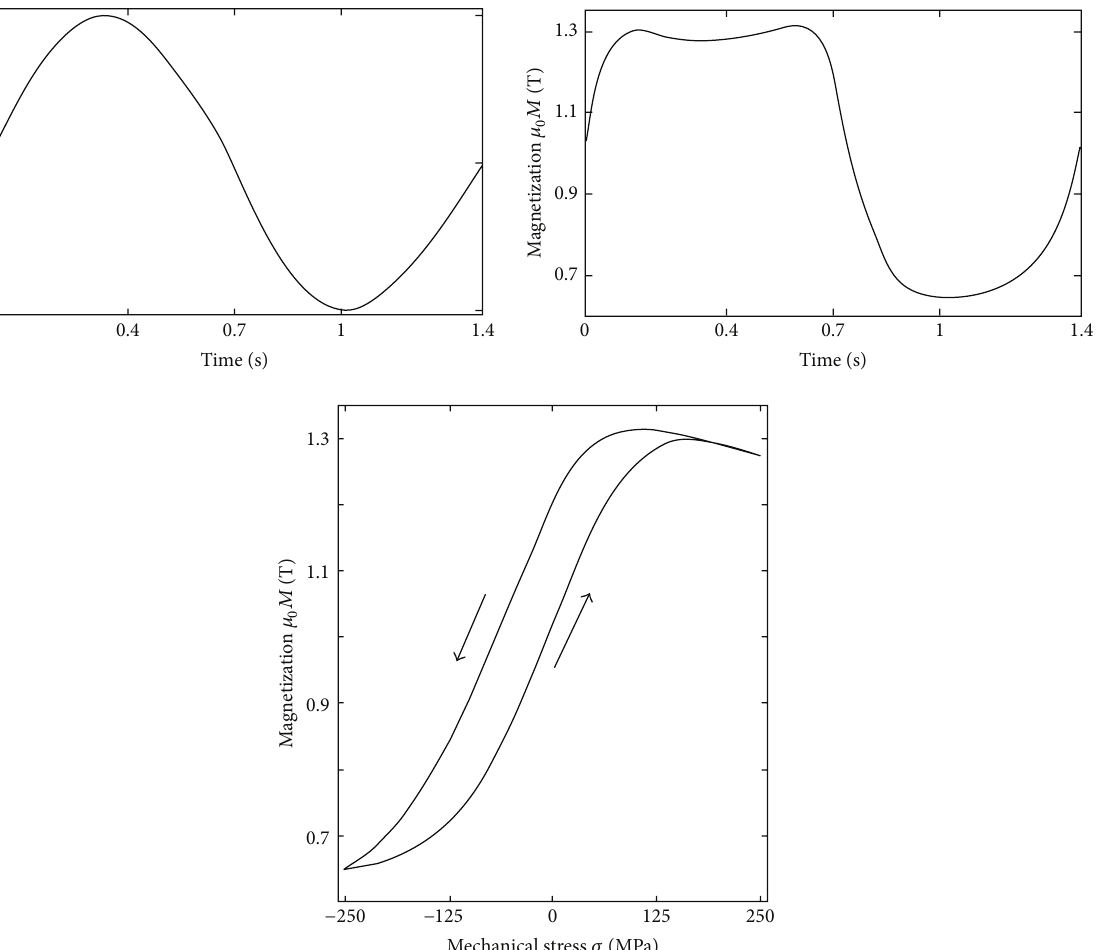
Figure 14: Stress inducted magnetization in low carbon steel ( 𝑅 𝑒 = 390 MPa, stress level below yield strength, static magnetic field 𝐻 = 800 A/m)